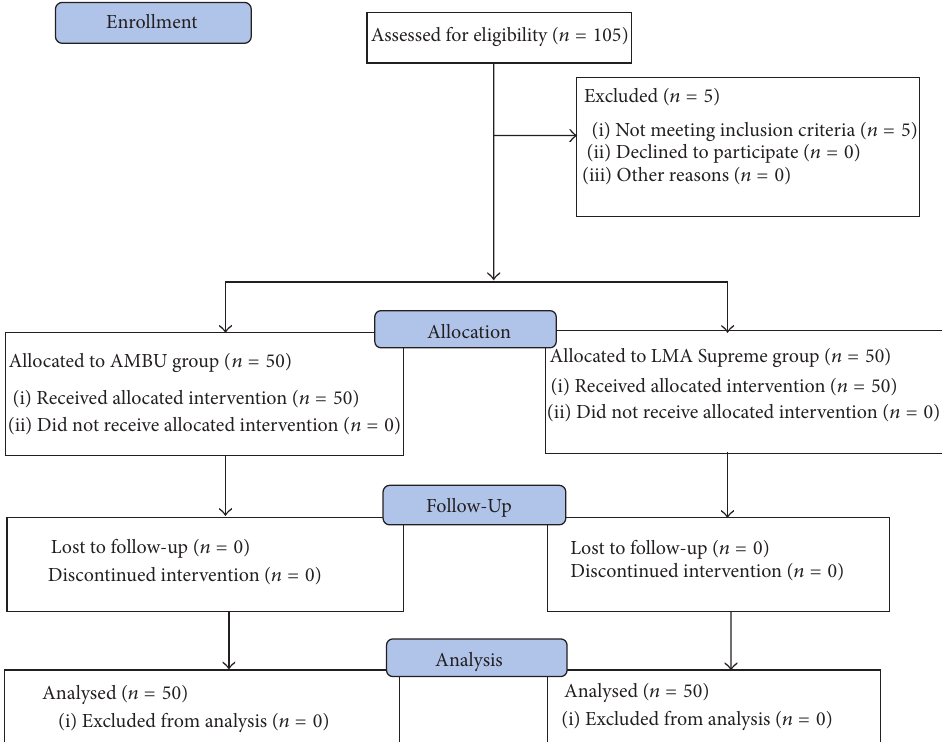
Figure 1: Flow of patients through the